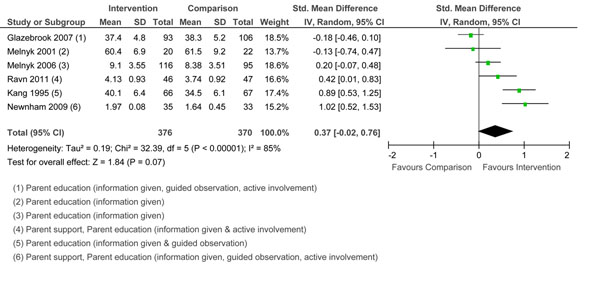
Forest plot of comparison: 1 Group, outcome: 1.5 Sensitivity/Responsiveness.